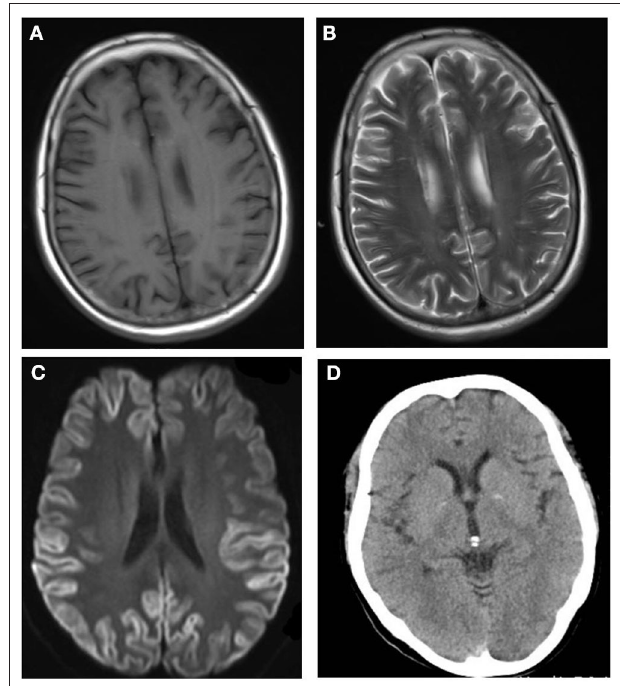
FIGURE 1 | No abnormalities are detectable on the T1-weighted (A) and T2-weighted (B) magnetic resonance imaging (MRI) sequences. The diffusion-weighted imaging (DWI; C ) shows the typical features of “cortical ribboning” in the cortex and subcortex of bilateral frontal, temporal, and occipital lobes on DWI (C) . On the apparent diffusion coefficient map (ABC; D ), there is low signal intensity in the cortex and subcortex of the bilateral frontal, temporal, and occipital